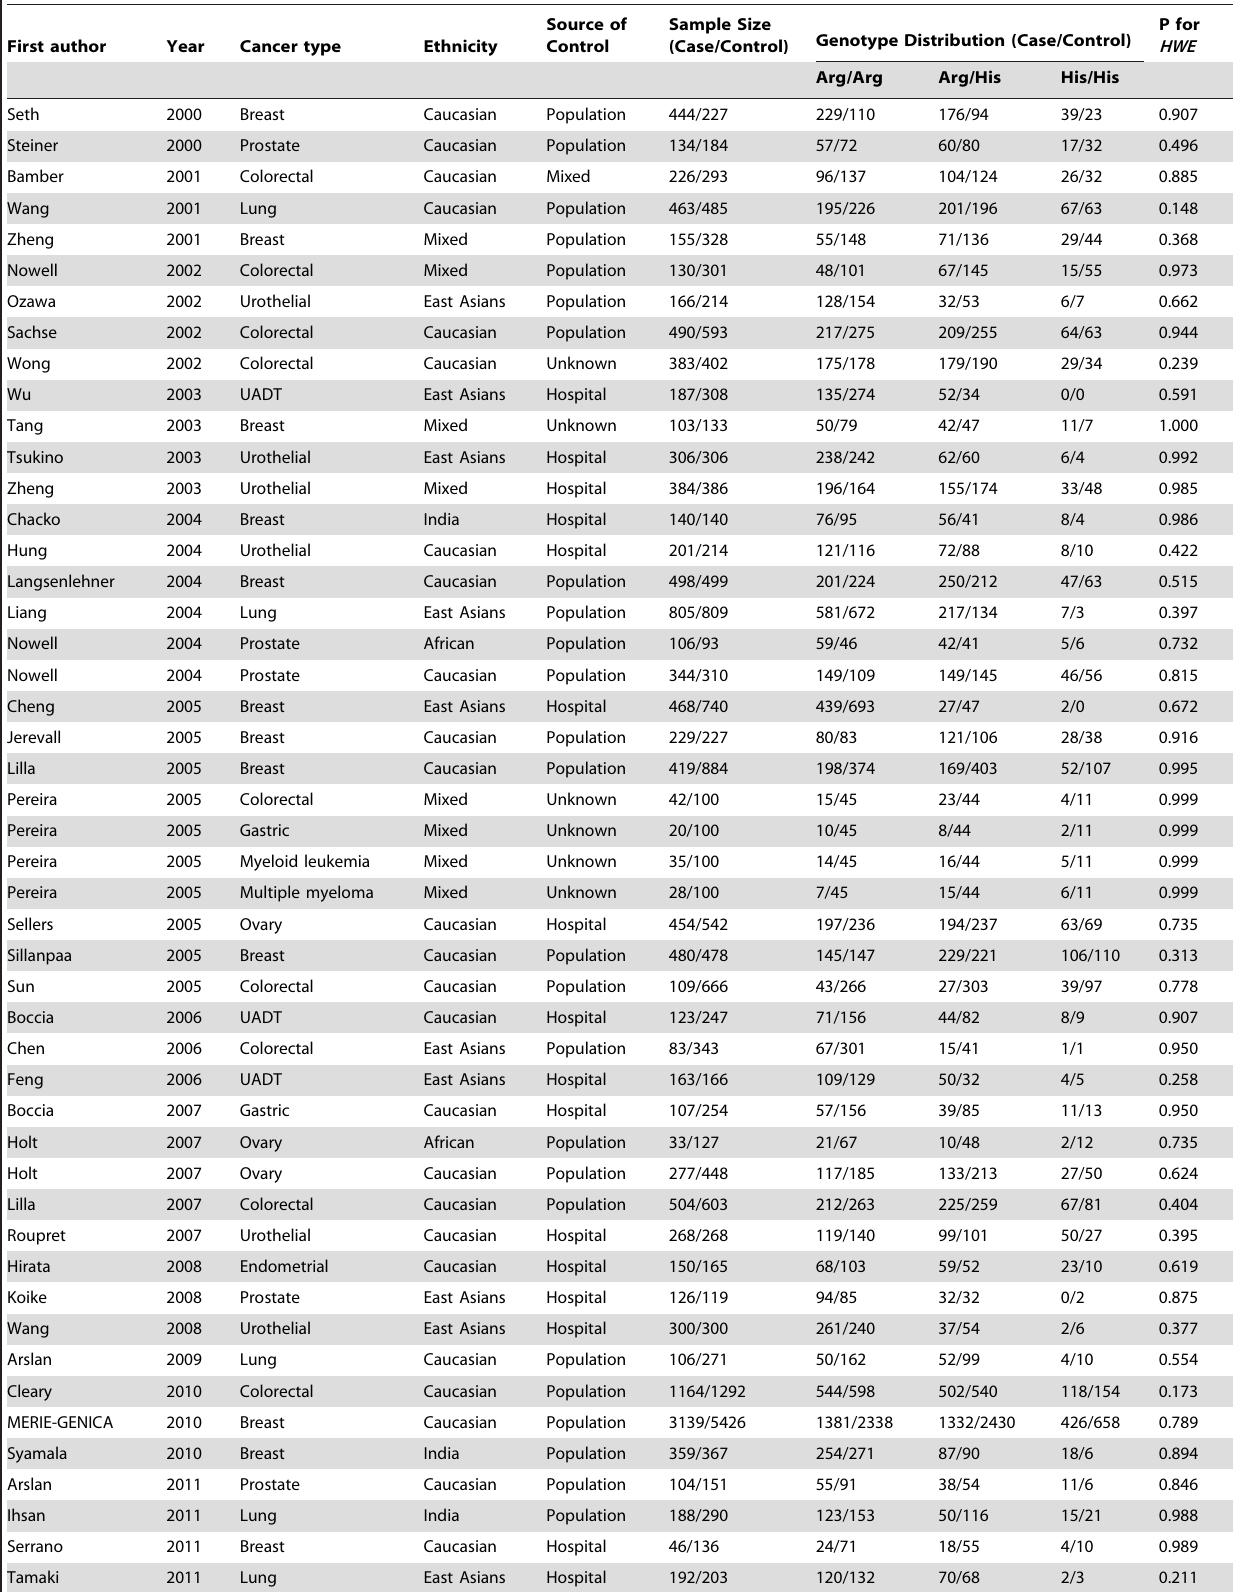
Table 1. Characteristics of studies included in the